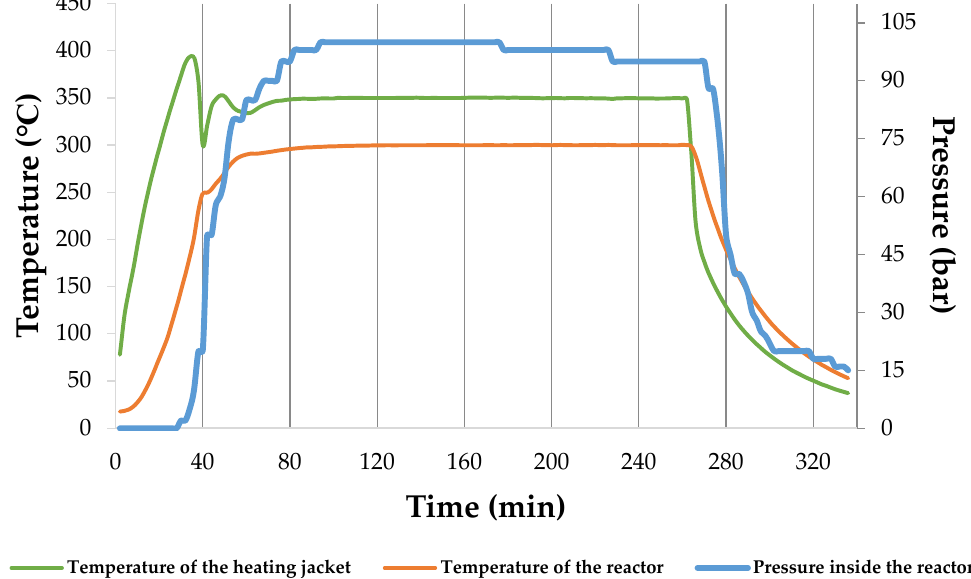
Figure 4. An example of temperature and pressure patterns during the process at 300 ◦ C in 180 min. Graphs presenting temperature and pressure patterns during the HTC process with different parameters are available in Appendix B (Figures A1 A8).